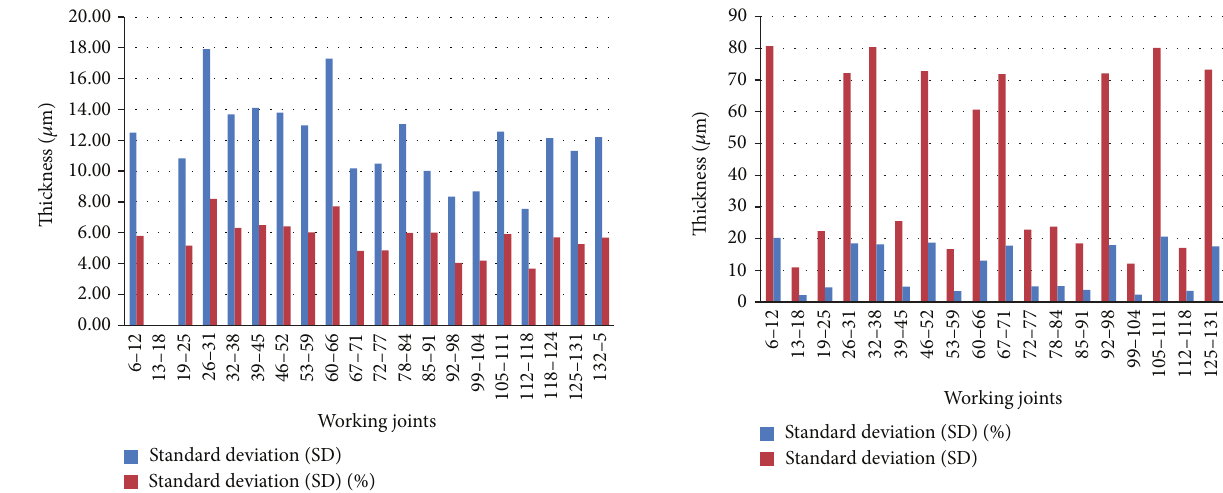
Figure 13: Overall standard deviation of paintings of internal shell (above the ring).